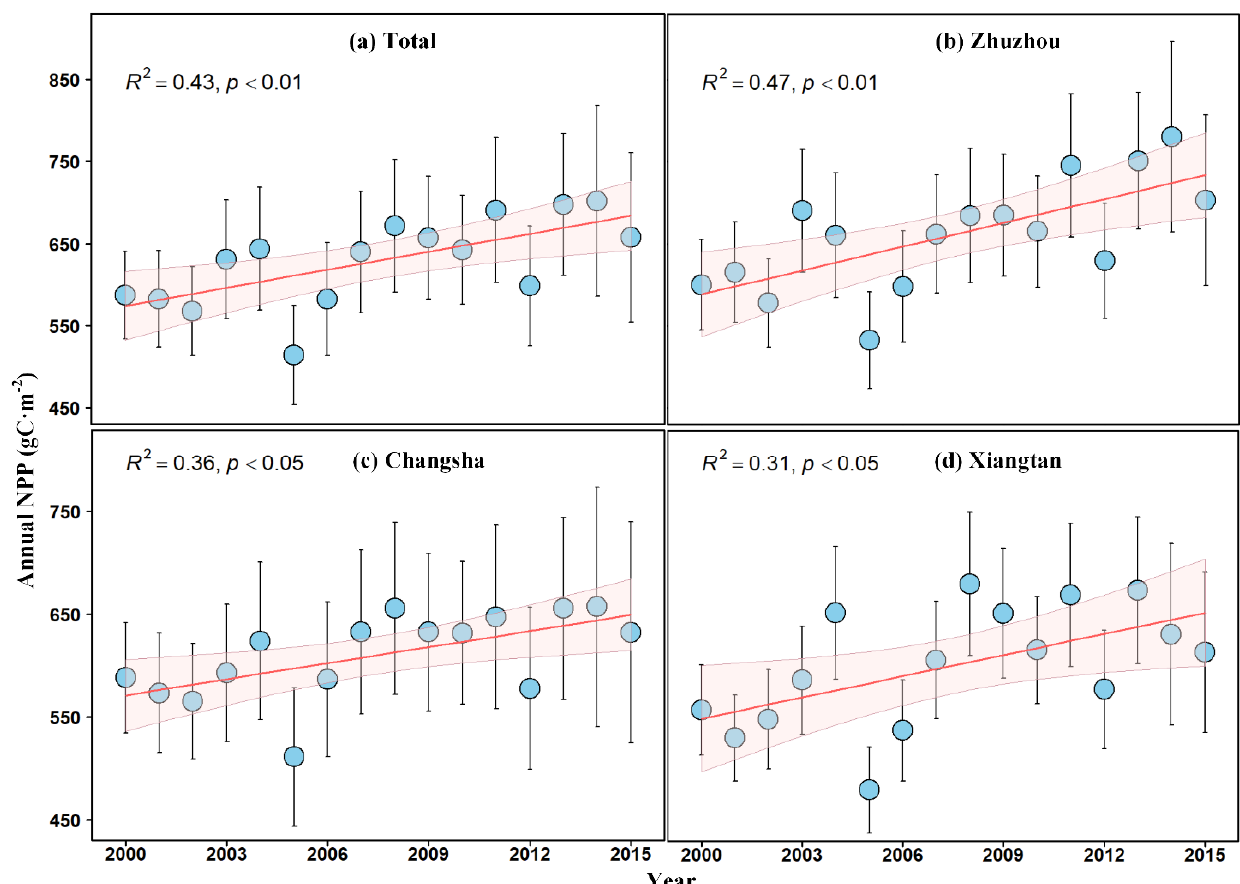
Figure 2. Temporal variation in annual NPP (gC • m − 2 ) in the CZT urban agglomeration from 2000 to 2015. ( a ) The total values for CZT; ( b ) the values for Zhuzhou; ( c ) the values for Changsha; ( d ) the values for Xiangtan. Note: The red line indicates the linear fitting during the period from 2000 to 2015. The p -value documents the significance. Error bars extending from the means document the standard deviation of annual NPP, while the light red region is the 95% confidence intervals of the linear model.